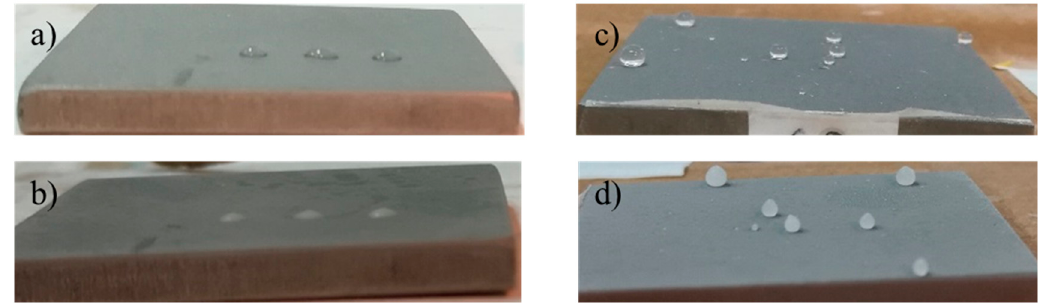
Figure 18 . Pictures of samples acquired at − 27 °C. Reference with water droplet before ( a ) and after ( b ) the icing at − 27 °C; coated sample with water droplets before ( c ) and after ( d ) the icing at − 27 °C.